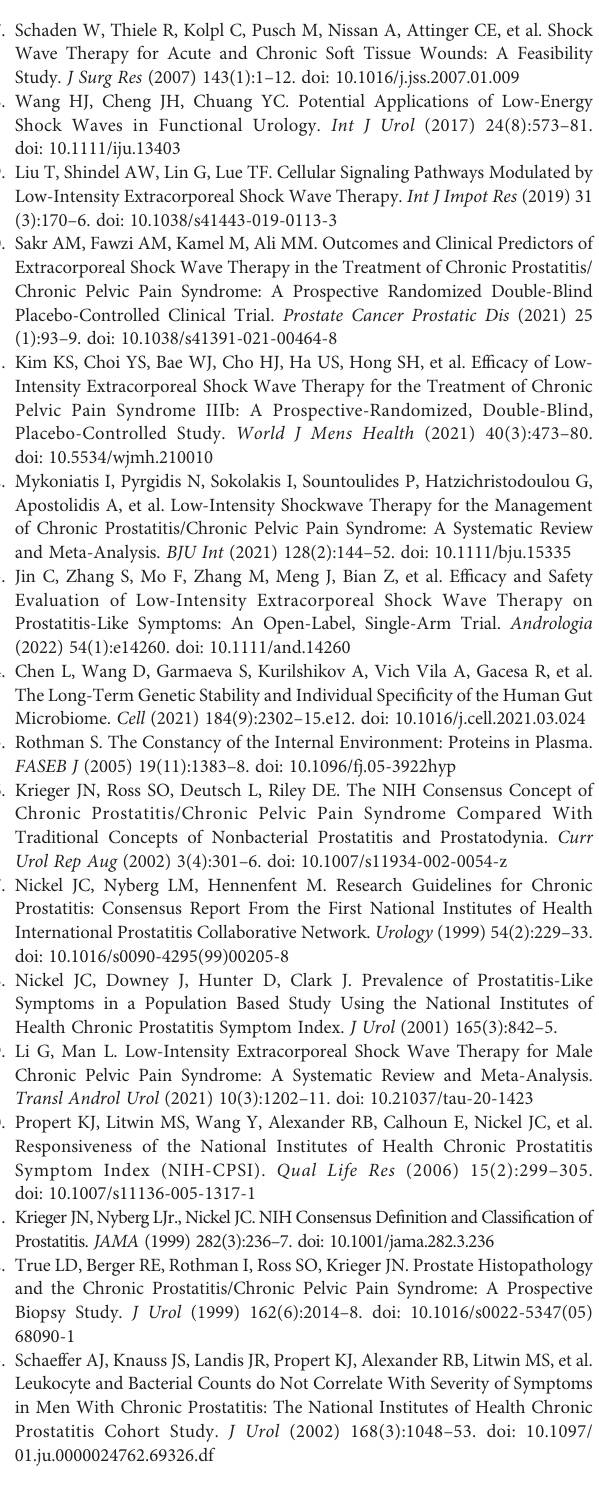
Supplementary Table 1 | The metabolites and corresponding index obtain from LASSO analysis. Supplementary Table 2 | Detail information of the